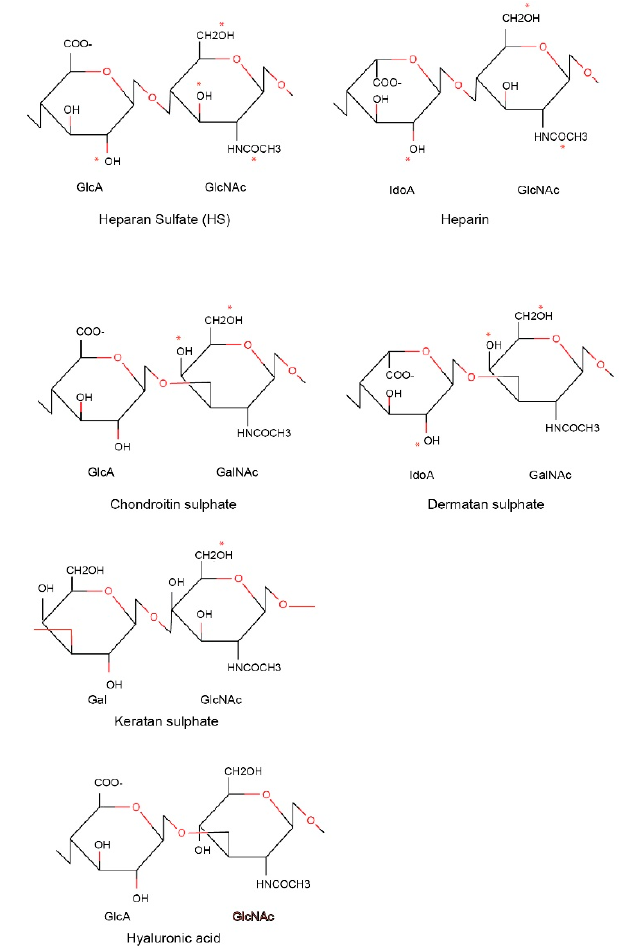
Figure 1. Structure of glycosaminoglycan chains. The repeating disaccharides in different types of glycosaminoglycan chains are presented. The different sulphation positions in each glycosaminoglycan (GAG) are marked by * in red.